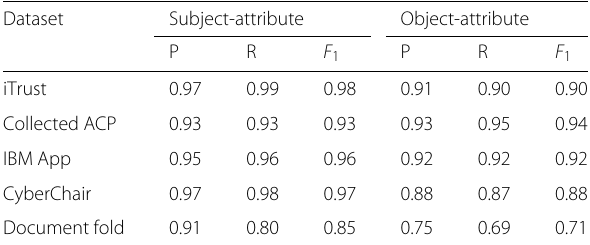
Table 5 Performance results of extracting attribute values using subject-attribute and object-attribute models (P, R, F 1 represent precision, recall and F 1 -score, respectively)